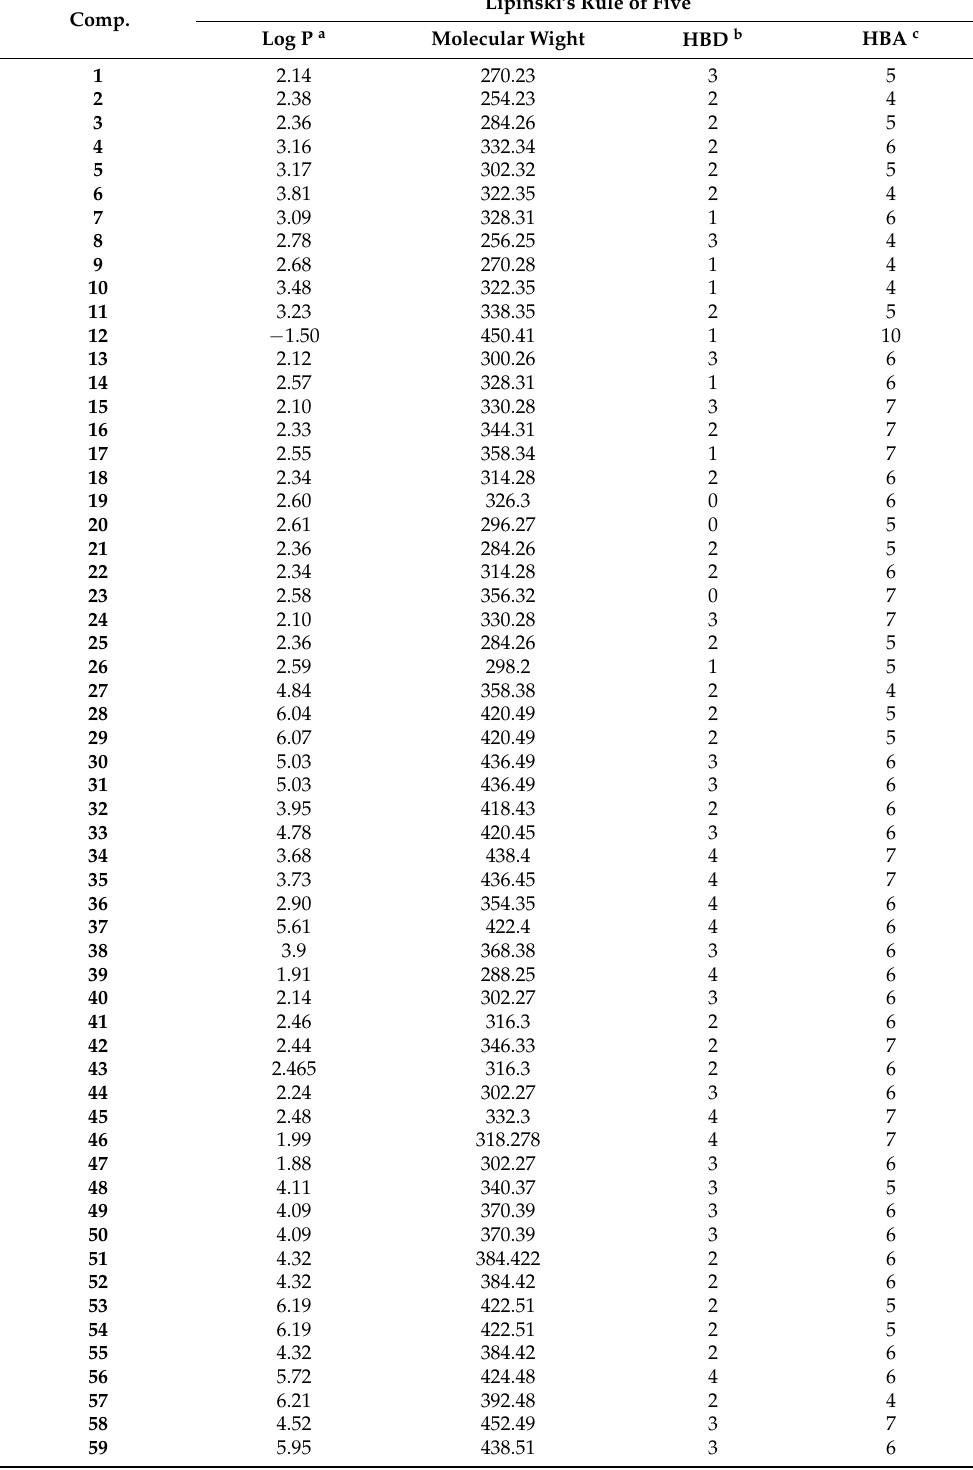
Table 1. physicochemical properties of the tested